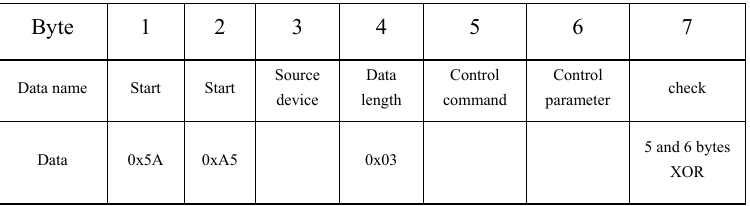
Table 1. Communication